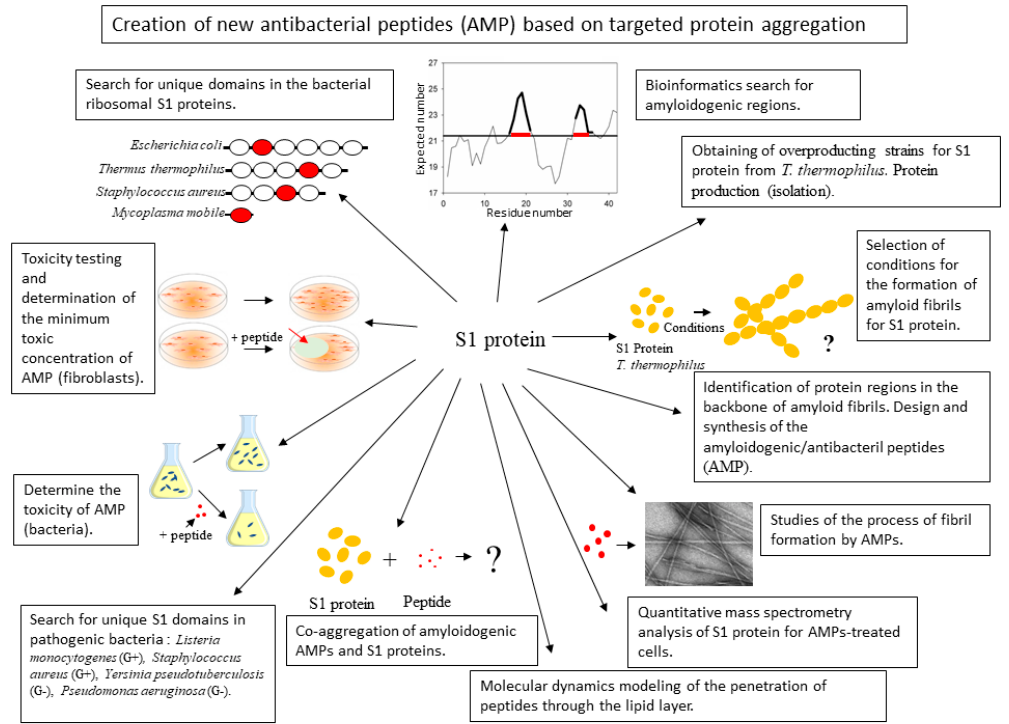
Figure 1. Schematic representation of the main challenges associated with the development of new antibacterial peptides.